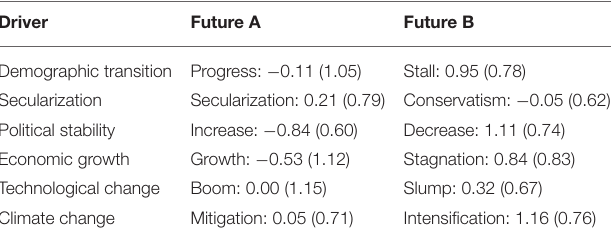
TABLE 5 | Mean expected change in the demand for migrants in Europe associated with each alternate future within each driver (with standard deviations between